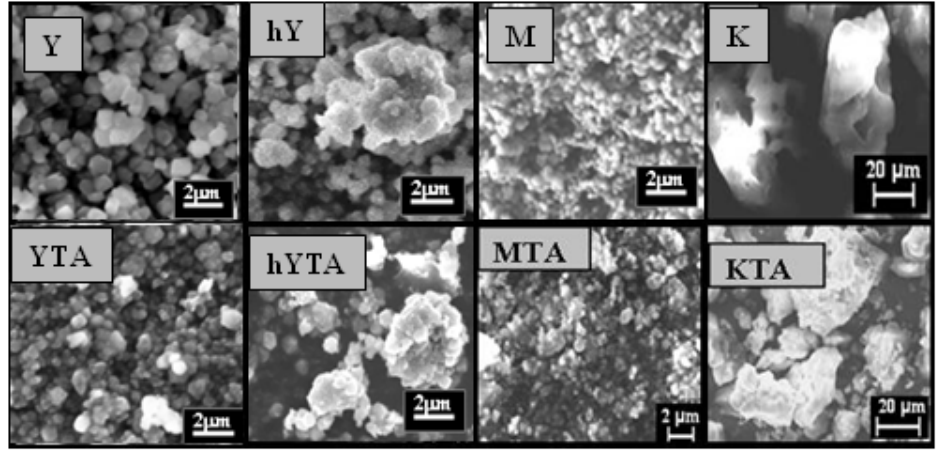
Figure 4. SEM images of the synthesized photocatalysts.